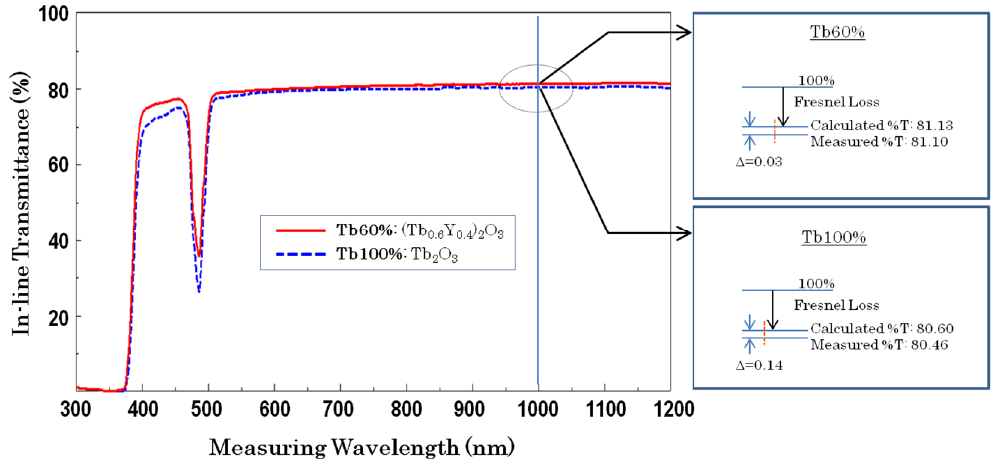
Figure 3. In-line transmittance curves of the (Tb 0.6 Y 0.4 ) 2 O 3 and Tb 2 O 3 ceramics (Sample thickness = 5 mm, optical-polished surfaces).